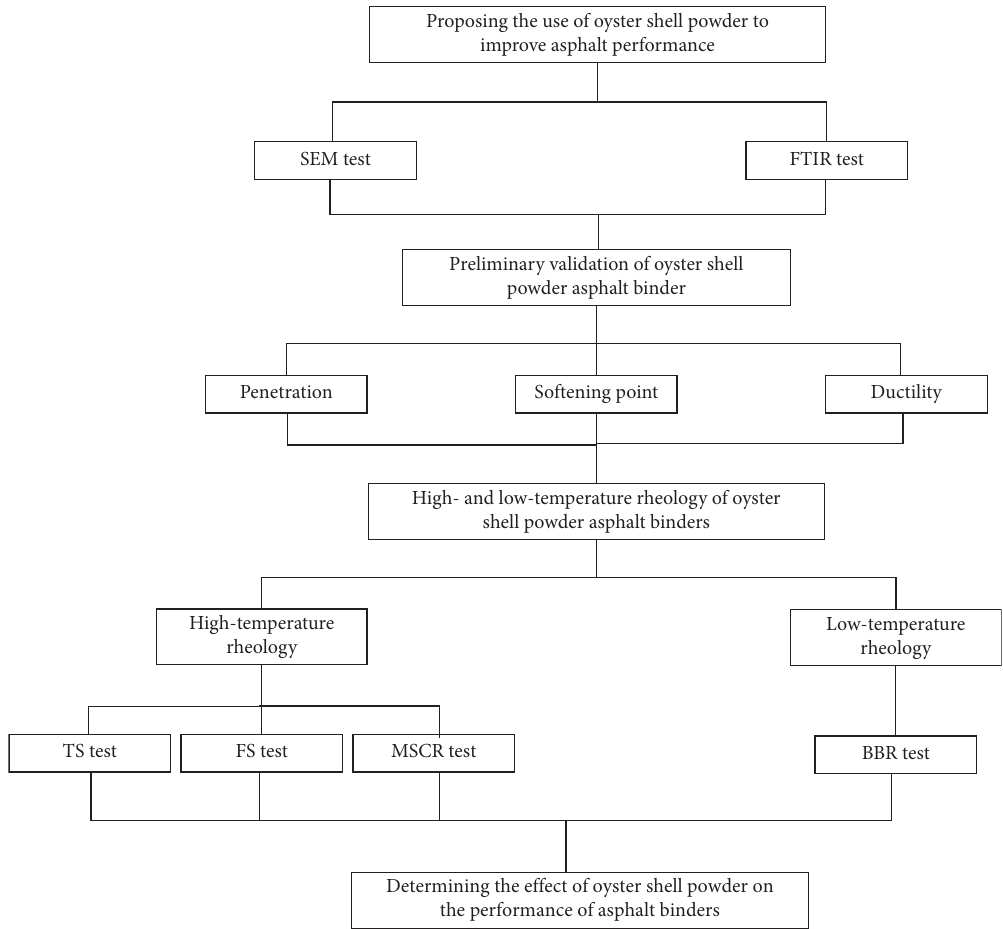
Figure 3: Research methodology flow chart.